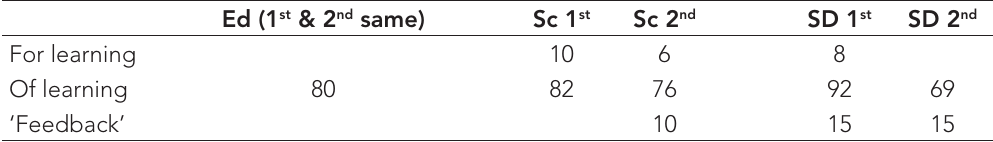
Table 1: Percentage rough definitions of SA provided that were classified as ‘for’ or ‘of’ learning, and including the word ‘feedback’ Ed (1 st & 2 nd same) Sc 1 st Sc 2 nd SD 1 st SD 2 nd For learning 10 6 8 Of learning 80 82 76 92 69 ‘Feedback’ 10 15 15 Note: Where percentages do not sum to 100, this indicates some respondents did not answer the question or gave an ambiguous answer. Ed = education staff; Sc = science staff; SD = staff developers.